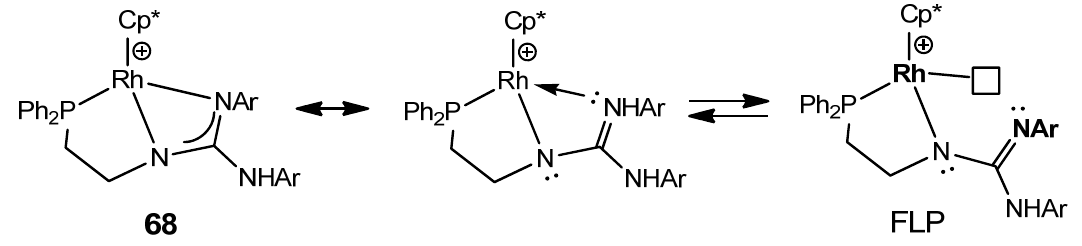
Figure 42. Bridging and arene coordination of guanidinato ligands in rhodium complexes. Not surprisingly, as well as several examples of rhodium complexes with guanidi- nato ligands are known, the organometallic chemistry of analogous iridium compounds is wide. In addition to reactivities parallel to those described for rhodium [137,148,150], there are interesting examples of the influence of these ligands on the behavior of the metal. For example, the presence of the lone pair of electrons on the uncoordinated NR 2 group increases the electron density of the ligand available for coordination to the metal. This obviously makes these ligands stronger donors than the related amidinato ligands. Consequently, if they coordinate to a metal in a low oxidation state, the possibility of reaching higher oxidation states increase. Thus, in the reactions of iridium guanidinato complexes with O 2 , the observed reactivity trends correlate well with both the electronic and steric properties of the substituents of the guanidinato ligands, allowing the stabili- zation and characterization of complexes with peroxo groups (Figure 43) [152–155]. Figure 43. Dioxygen iridium complex.